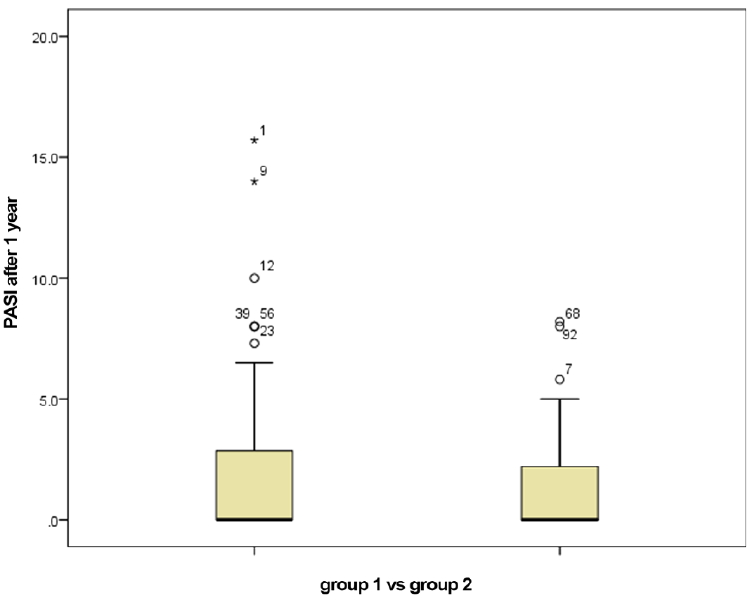
Figure 1. PASI after 1 year of biological therapy for group 1 (smokers) vs. group 2 (non-smokers).